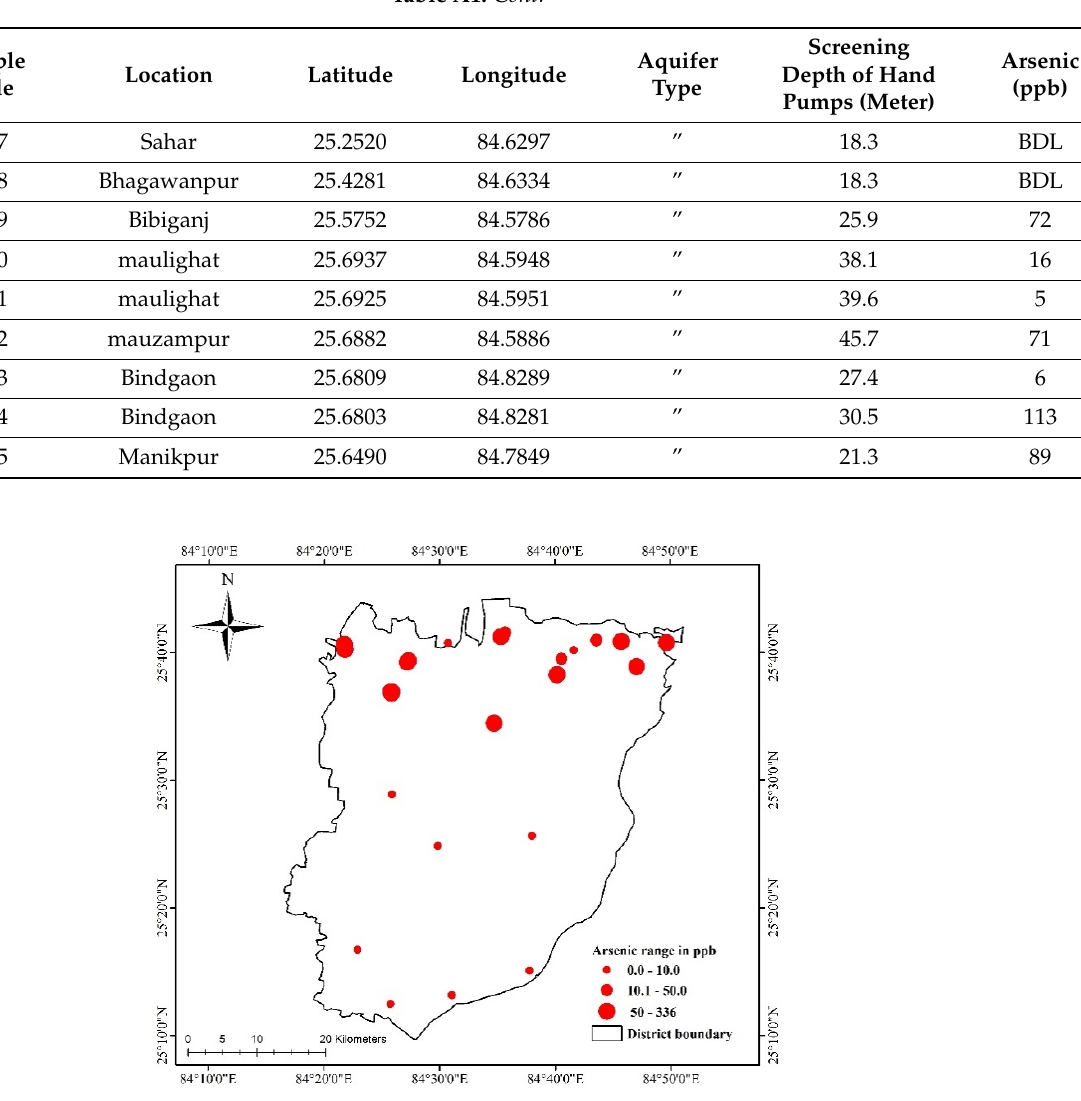
Figure A1. Arsenic distribution map in the study area.